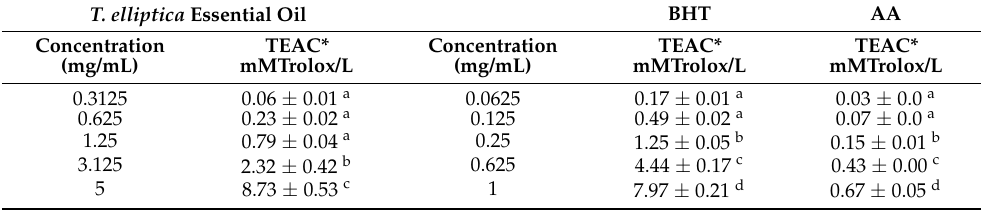
Table 3. Antioxidant activity of T. elliptica essential oil measured by FRAP method. T. elliptica Essential Oil